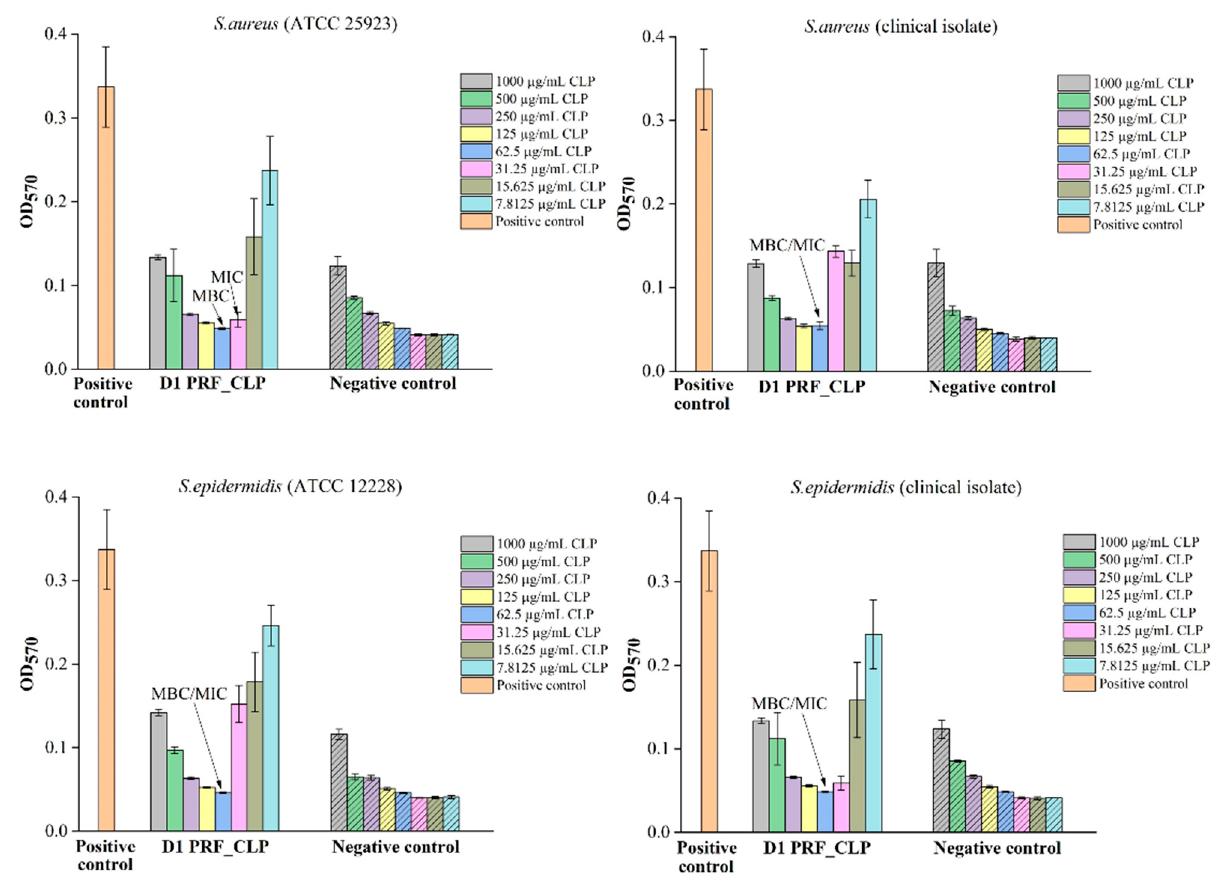
Figure 7. Antibacterial properties of PRF_CLP samples at various concentrations of CLP solution for 4 bacteria strains ( S. aureus (ATCC 25923), S. epidermidis (ATCC 12228), S. aureus (clinical isolate) and S. epidermidis (clinical isolate) for PRF_CLP samples prepared from donor 1 blood. Pure bacterial suspension (10 6 CFU/mL) as a positive control and pure sterile Mueller – Hinton broth as a negative control were used.